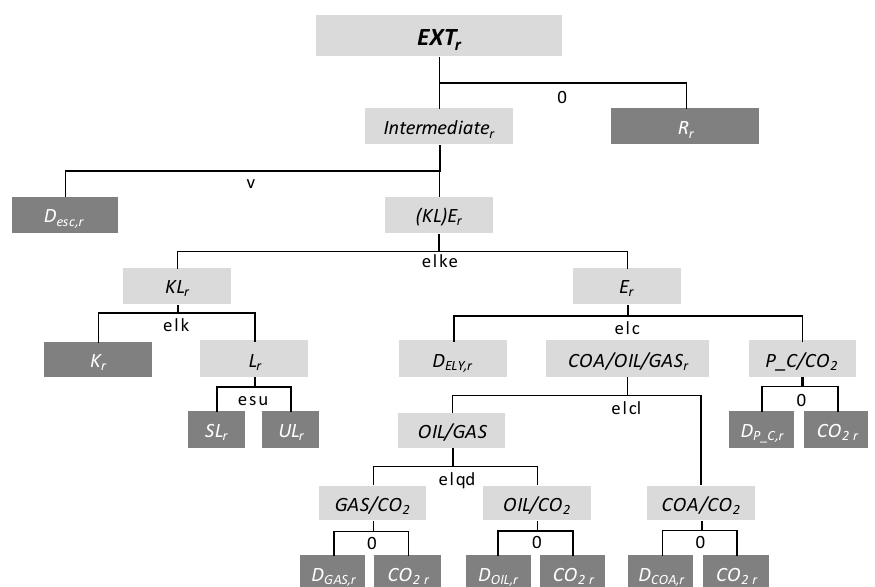
Figure A5. Nesting structure of resource using Other Extraction sector without process emissions in production in the CGE model.